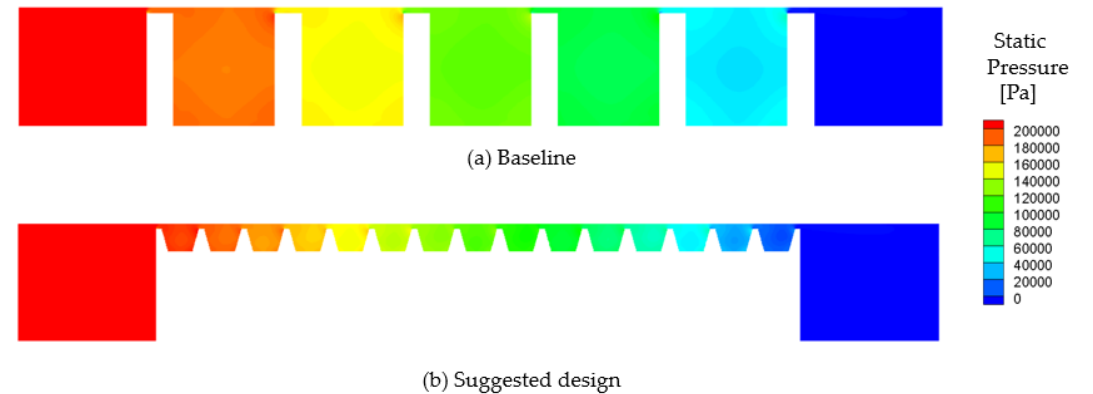
Figure 20. Contours of the static pressure in the labyrinth seal under a pressure ratio of 2 for ( a ) baseline and the ( b ) suggested design. Table 6. Jet divergence angle and discharge coefficients for the baseline and suggested optimal geometry for a labyrinth seal under pressure ratios of 1.1, 1.5, and 2.